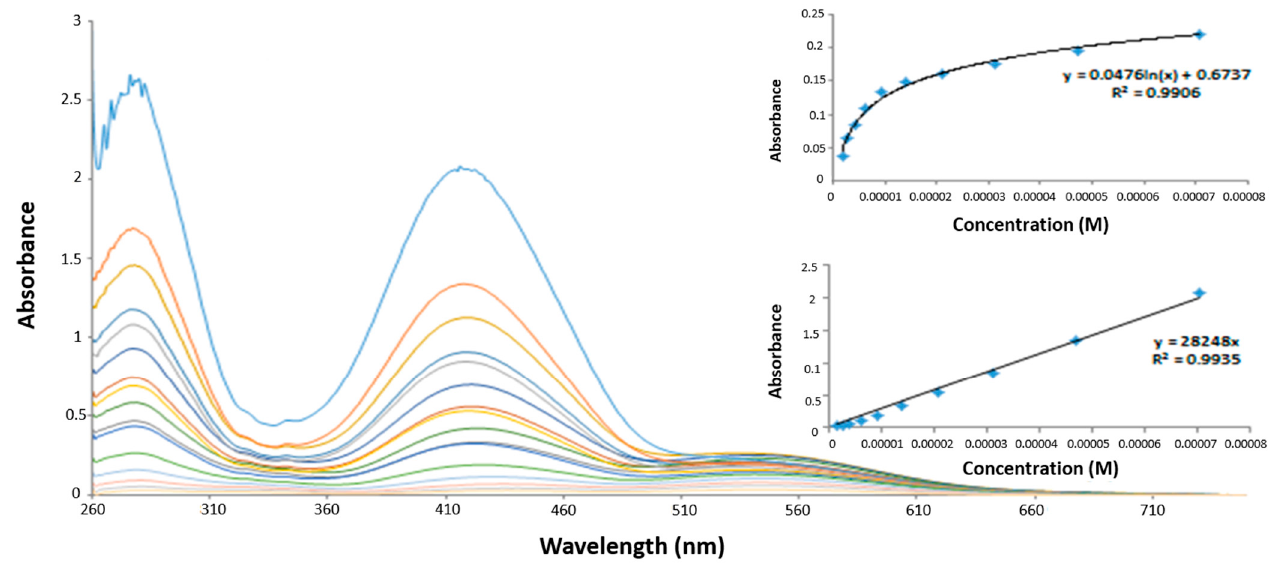
Figure 4. Changes in UV/Vis spectrum of SN2 upon increasing concentration in DMSO (0.1–70 µM). Insets: Plots of absorbance at 420 nm and 545 nm as a function of increasing concentration of SN2 .